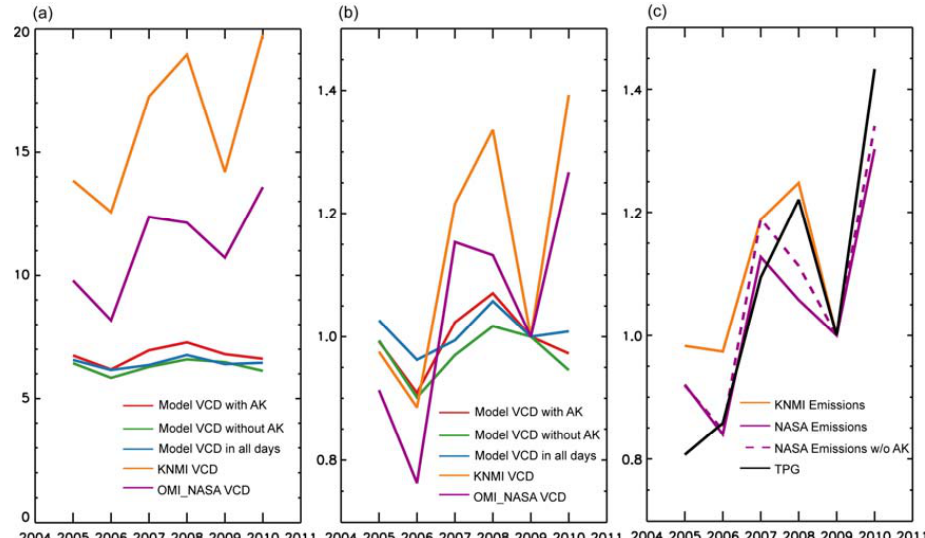
Fig. 4. (a) Changes in January mean VCDs of NO 2 (10 15 moleccm − 2 ) from 2005 to 2010 with respect to OMI retrievals. (b) Corresponding changes in VCDs of NO 2 relative to values in January 2009. (c) Changes in emissions of NO x derived from OMI relative to values in January 2009; also shown is changes in TPG (TWhday − 1 ) relative to January 2009. See Sect. 6.2 for the derivation of emissions of NO x